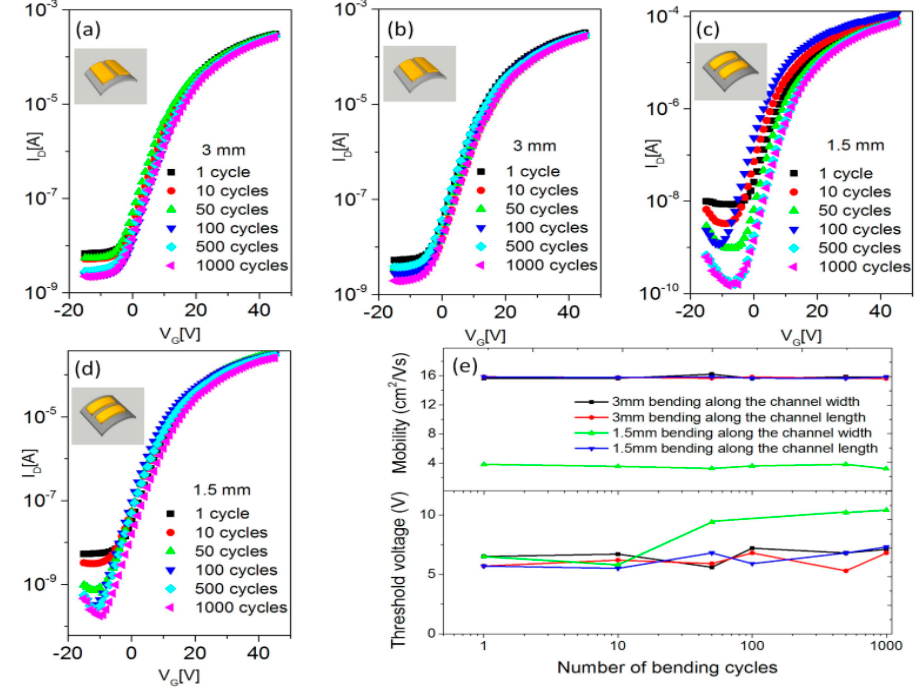
Figure 13. Transfer characteristics of TFTs repeatedly bent along the channel width and along the channel length with different radius: ( a ) 3 mm and ( b ) 1.5 mm as along the channel width, ( c ) 3 mm and ( d ) 1.5 mm along the channel length. ( e ) the mobility and threshold voltages as a function of the number of bending cycles [160].